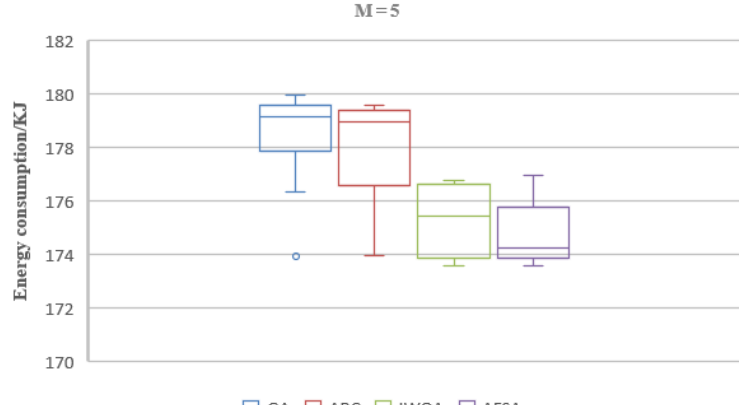
Figure 9. Box plot of run results when the population is 5.